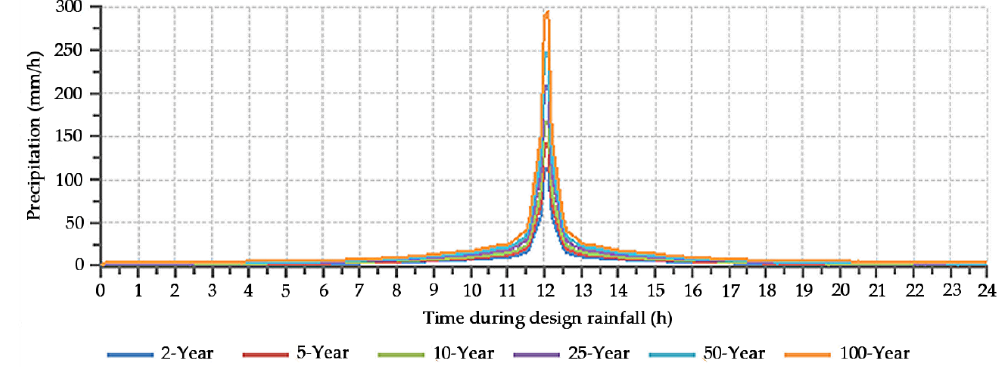
Figure 12. Precipitation considered in the model for the Technology Centre in Florianópolis.